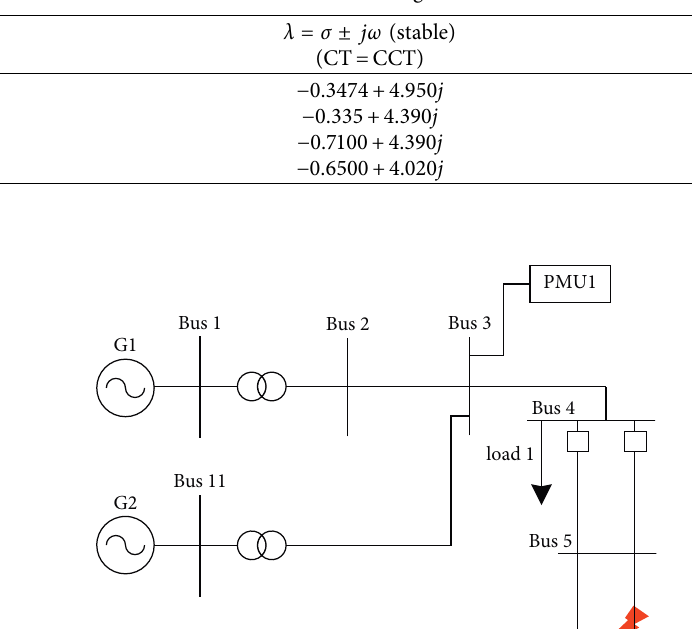
Figure 11: Voltage angle diference between bus 2 and bus 3 for diferent generated power in cases CT � CCT and CT > CCT. Table 3: SMIB eigenvalues.